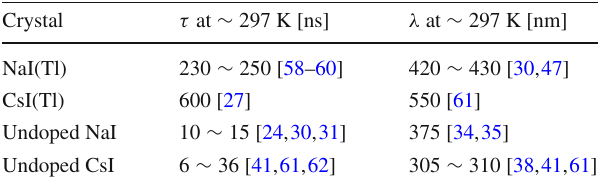
Fig. 11 Relativescintillationyieldsandafterglowratesofvariouscrys- tals as a function of temperature. The scintillation yield of undoped CsI is taken from Ref. [25], the yields of undoped NaI and NaI(Tl) are from Ref. [26]. The afterglow rates are from Ref. [57] Table 3 Scintillation wavelength λ and decay time τ of Tl-doped and undoped NaI, CsI crystals at room